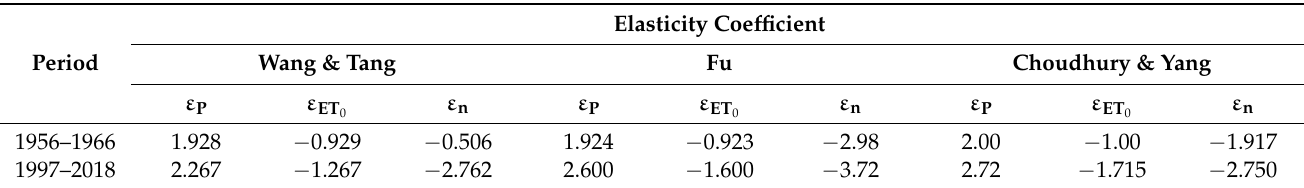
Table 3. Sensitivity of R to P, ET 0 and n for the three Budyko methods 1956–1996 (base period) and 1997–2018 (anthropogenic impact period) in the Kuye